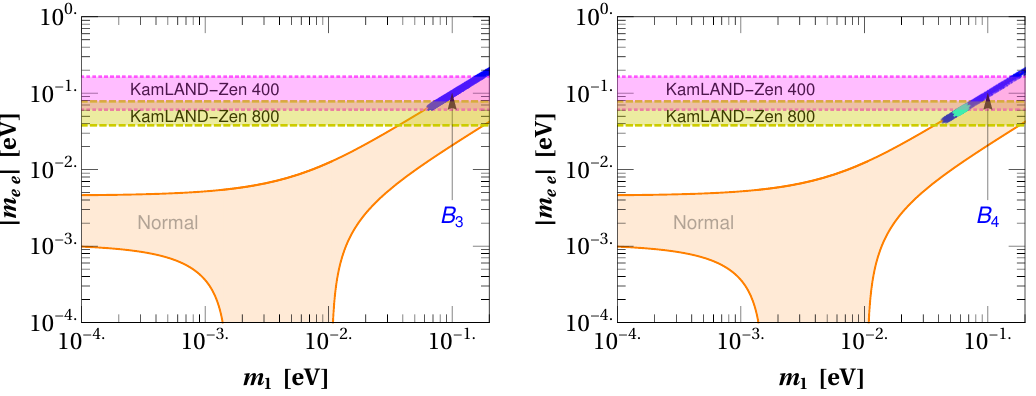
Figure 4 . Predictions for the e(cid:11)ective Majorana neutrino mass j m ee j vs the lightest neutrino mass m 1 . The 3 (cid:27) allowed parameter space of j m ee j using the latest global-(cid:12)t data is shown by the light-orange band [4]. The bound on j m ee j from the KamLAND-Zen 400 [118] collaboration has been shown by the light-magenta horizontal band, whereas the (cid:12)rst results of the KamLAND-Zen 800 [122] collaboration is outlined by the lighter-green band. Predictions for j m ee j for B 3 ; and B 4 are shown by the blue (cyan) patch at 3 (cid:27) (1 (cid:27) ).